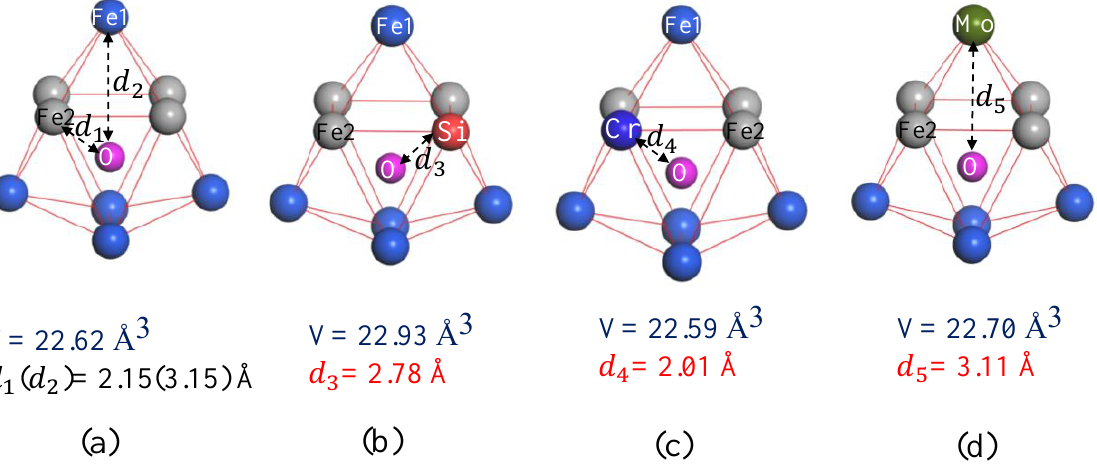
respectively, demonstrating that the strain during the formation of Si- and Mo-alloys is relaxed and reduced continuously. On the contrary, the 𝐸 𝑏𝑑 between Cr–O is 0.02 eV, showing that the strain is unrelaxed and increased in the process of forming a Cr-alloy. loying elements. In Figure 5, the volumes of CTPs with Si and Mo expand to 22.93 Å 3 and 22.70 Å 3 , respectively, compared with that of the pure GB (22.62 Å 3 ), which provide larger space to accommodate O atoms. However, the volume of CTP in Cr-alloyed GB is con- tracted to be 22.59 Å 3 .